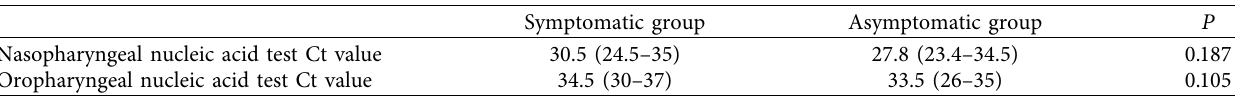
Table 2: Nasopharyngeal and oropharyngeal nucleic acid Ct values in the symptomatic and the asymptomatic groups.